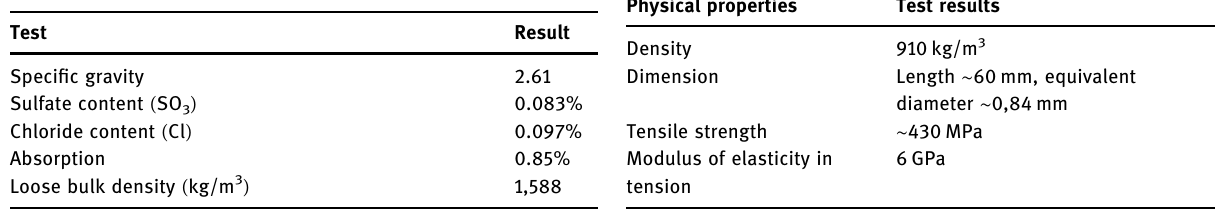
Table 5: Physical and chemical test results of the coarse aggre -